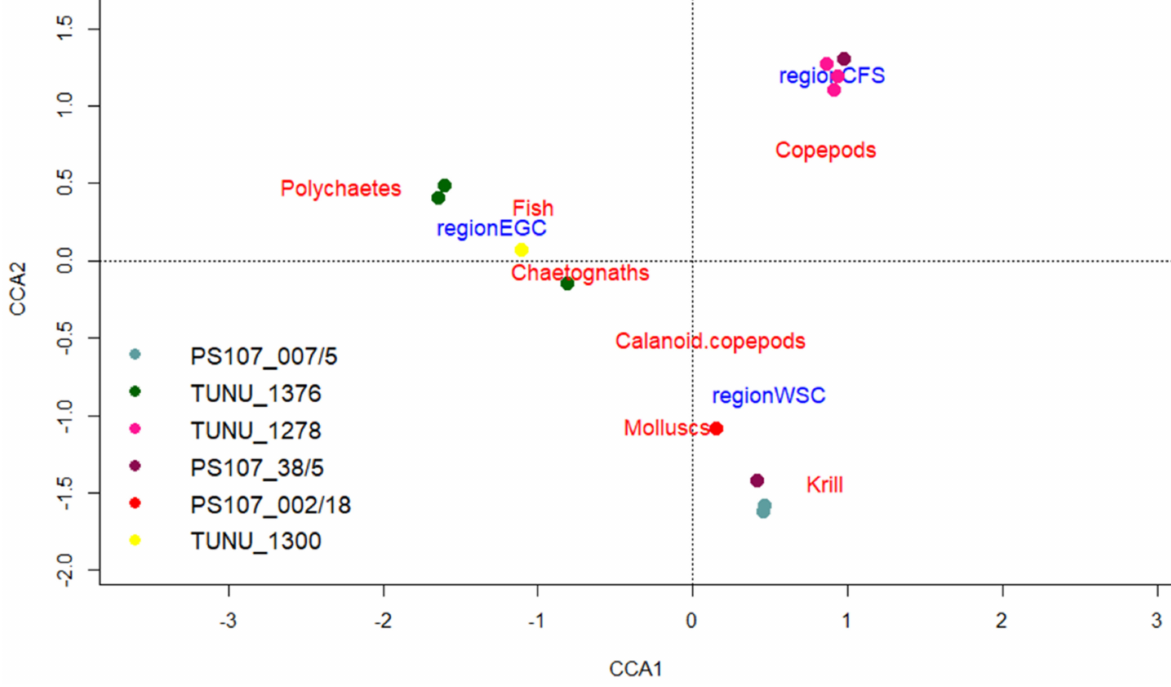
Figure 4. Canonical correspondence analyses (CCA) of the spatial variation of prey items for T. libellula . Colors indicate different stations; regions are identified by geographical region indi- cated in Figure 1. Only 50% of the most abundant prey species are displayed. The first axis (CCA1) separates the EGC region from the other two regions, with the EGC region being located on the left-hand side. The second axis (CCA2) separates the two Atlantic regions from each other, with the CFS regions in the upper part and the WSC regions in the lower